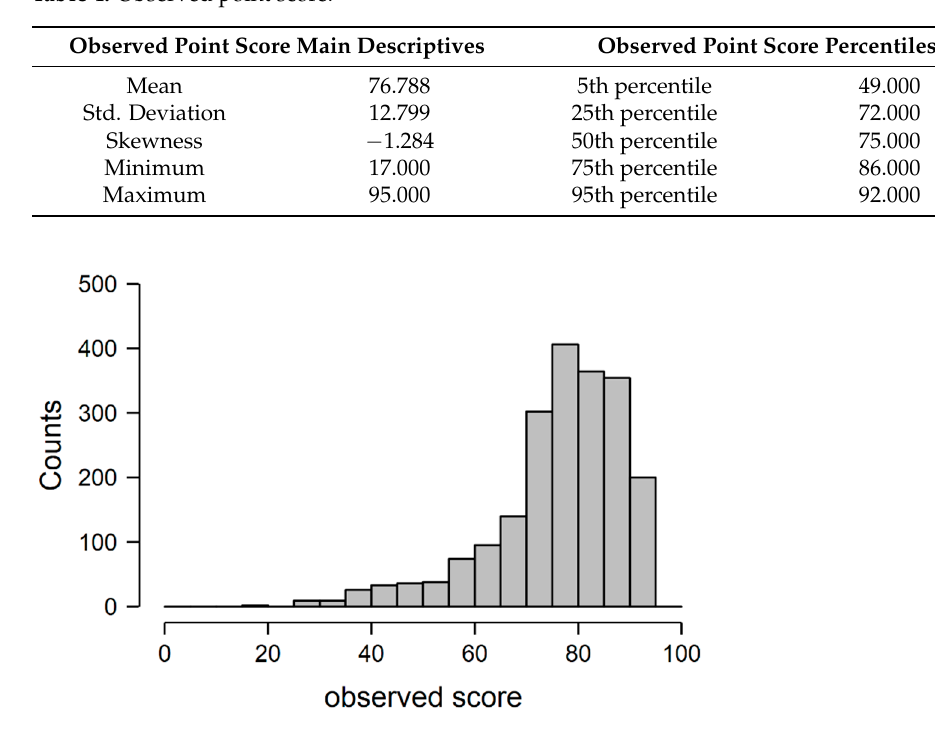
Figure 3. Observed point score histogram.